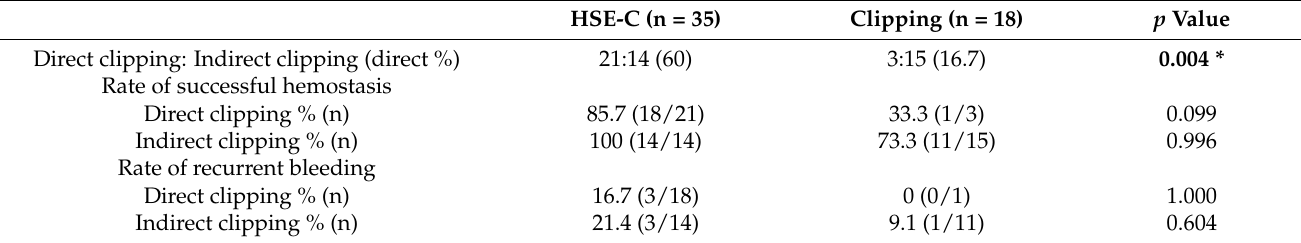
Table 3. Clinical outcomes of patients according to the clip application method (direct vs. indirect).